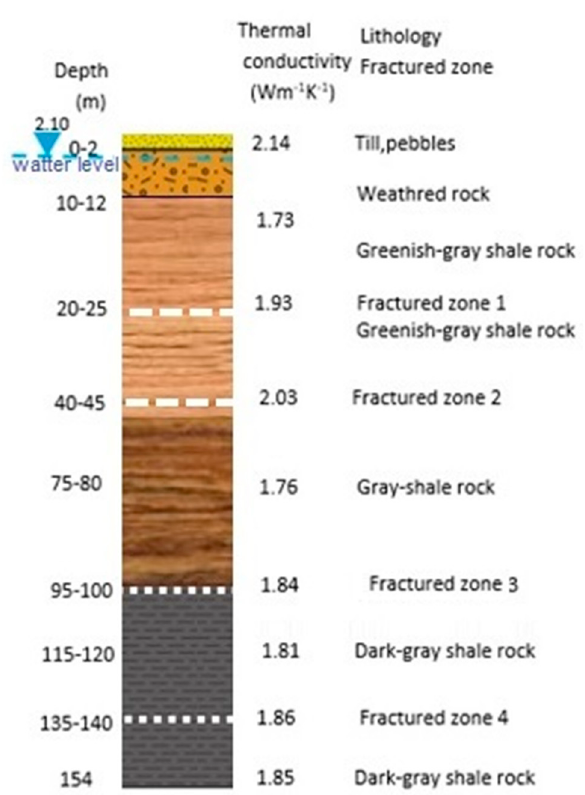
Figure 6. Thermostratigraphic log of the 1UBHE at the INRS experimental site, with layered TC from Pambou et al. [19] and geological cross-correlation based on borehole logs from Raymond et al. [10].